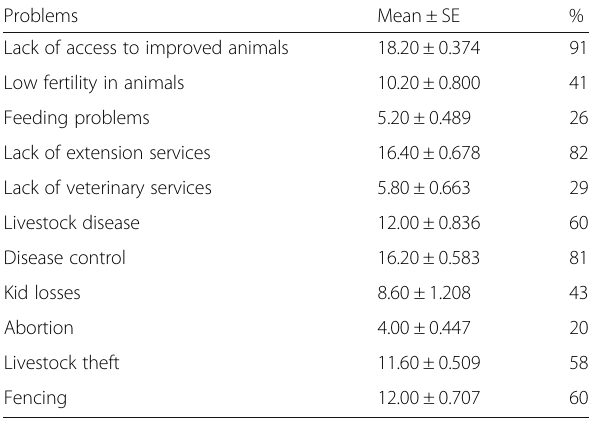
Table 7 Constraints for goat farmers in rural areas of the Nile Delta in Egypt